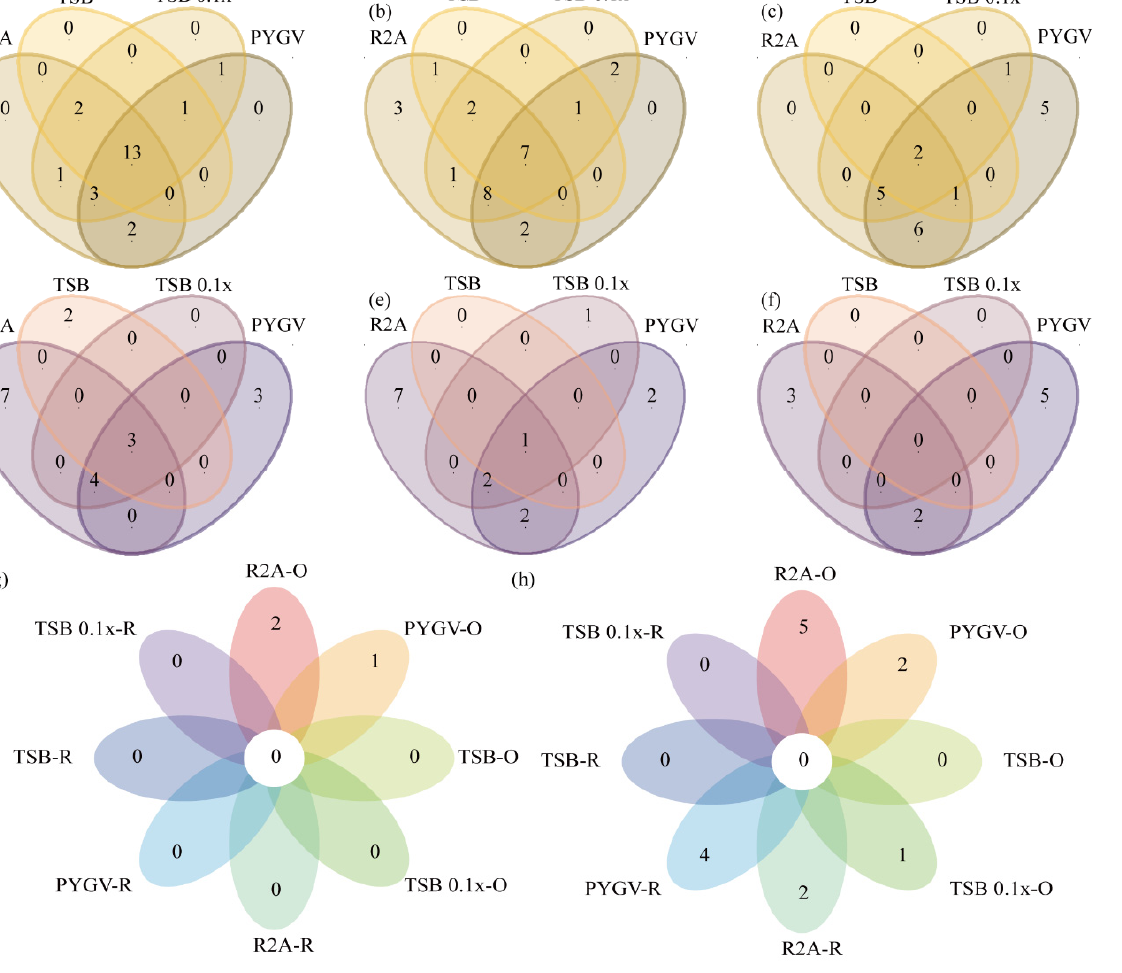
Figure 5. Taxonomic diversity as a function of different culture temperatures, media, and pre-treat- ments. ( a – c ) Venn diagram demonstrating the genera isolated from samples cultured in R2A, PYGV, TSB, and TSB 0.1x media under normal culture ( a ), oxidation ( b ), and radiation ( c ) conditions at HT. ( d – e ) Venn diagram demonstrating the genera isolated from samples cultured in R2A, PYGV, TSB, and TSB 0.1x media under normal culture ( d ), oxidation ( e ), and radiation ( f ) conditions at LT. ( g – h ) Unique genera isolated from samples cultured in different media under oxidation (O) and radi- ation (R) conditions at HT ( g ) and LT ( h ).